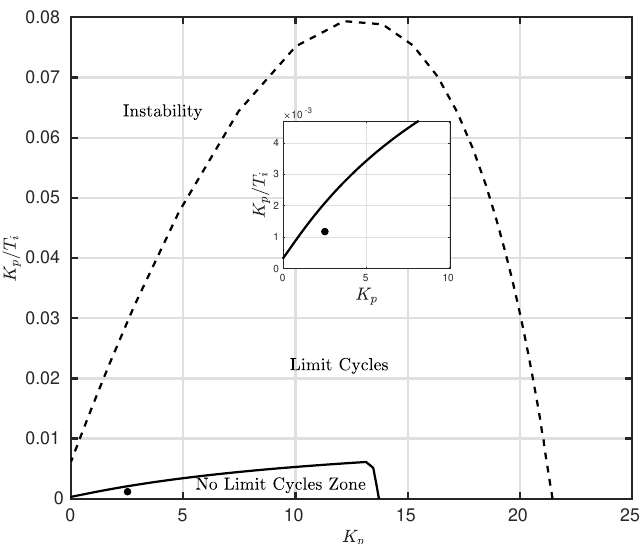
Figure 4. Stability region for nighttime